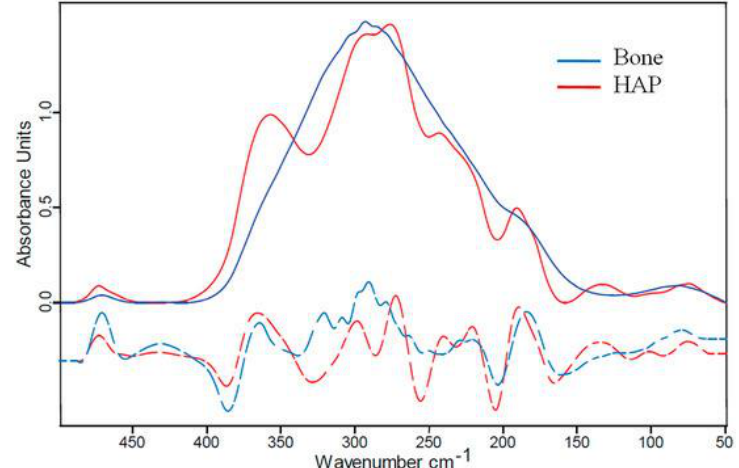
Figure 2. Far-IR (Far InfraRed) spectroscopy of bone. Blue line: bovine bone; red line: hydroxyapatite (HAP) powder [35].